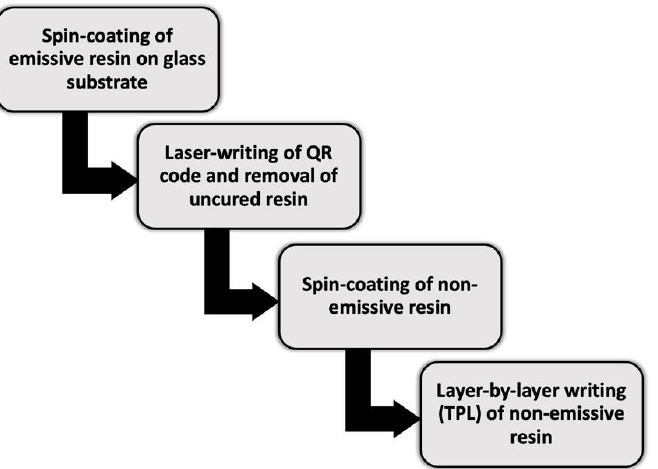
Figure 6. Simplified flowchart of the fabrication process proposed by Jaiswal et al. [26] to produce UV-visible micron-sized QR codes for TPL parts.